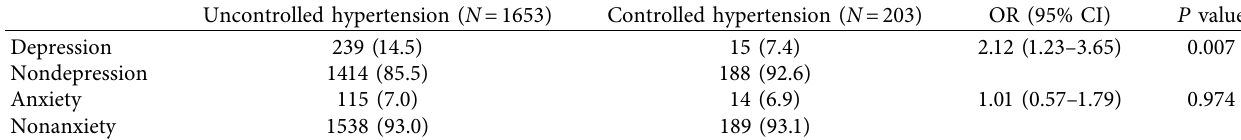
Table 2: Association of depression and anxiety in patients with uncontrolled hypertension.